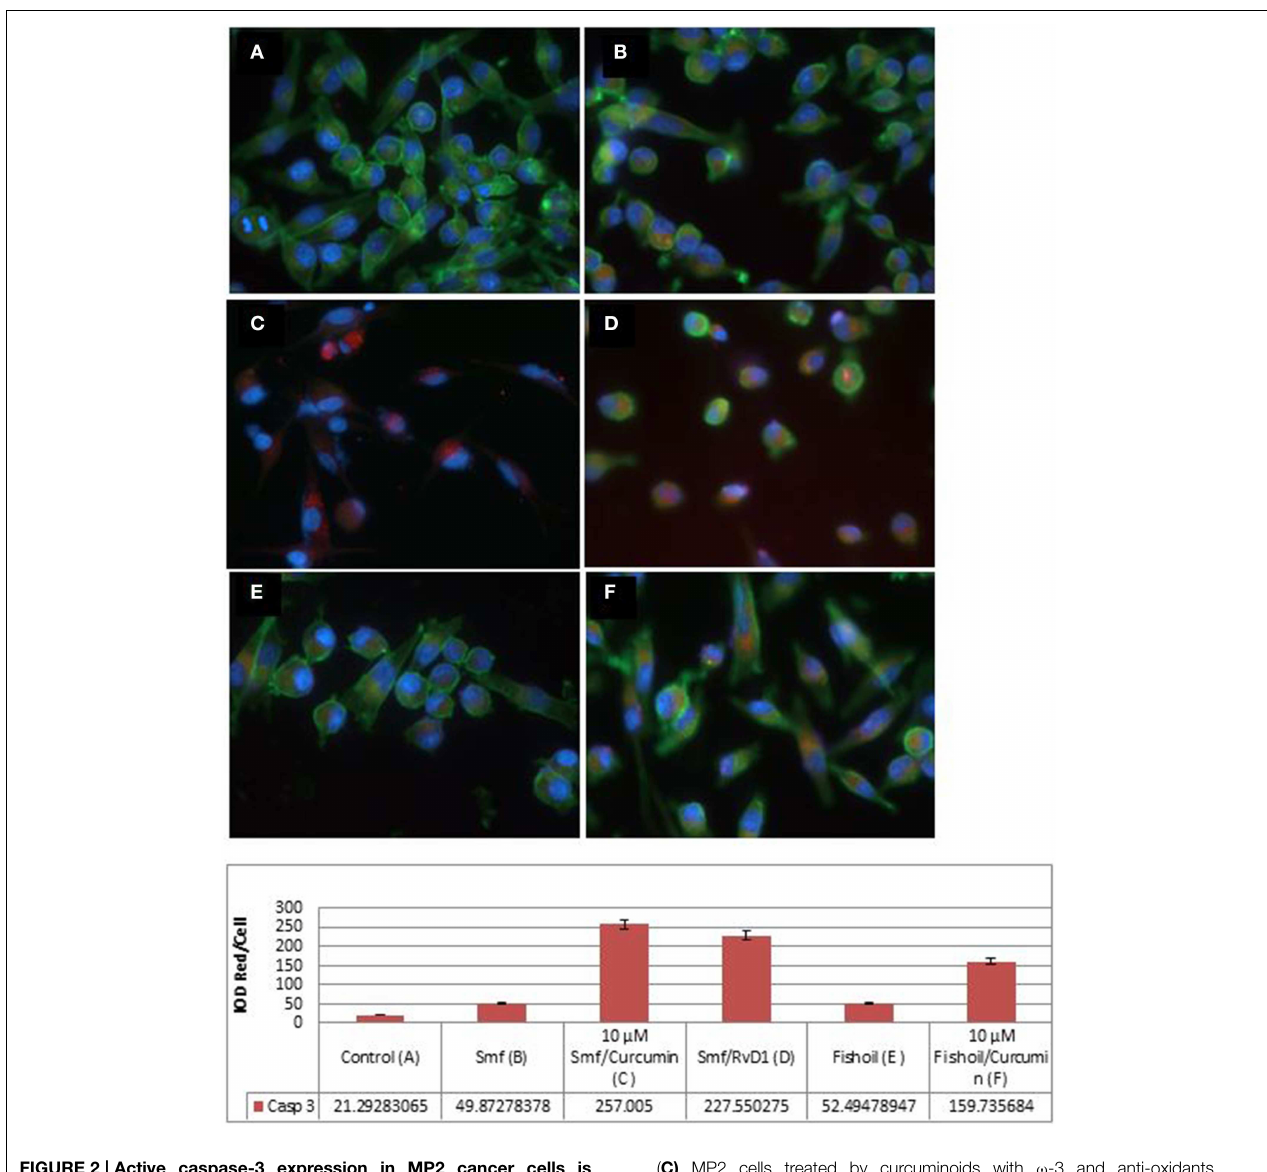
FIGURE 2 | Active caspase-3 expression in MP2 cancer cells is potentiated by curcuminoids and ω -3 or Resolvin D1. The MP2 cells were stained by phalloidin (green) and by rabbit antibody to active caspase-3/anti-rabbit ALEXA568 (red). ( A) Untreated MP2 cells; ( B) MP2 cells treated by ω -3 with anti-oxidants (Smartfish);